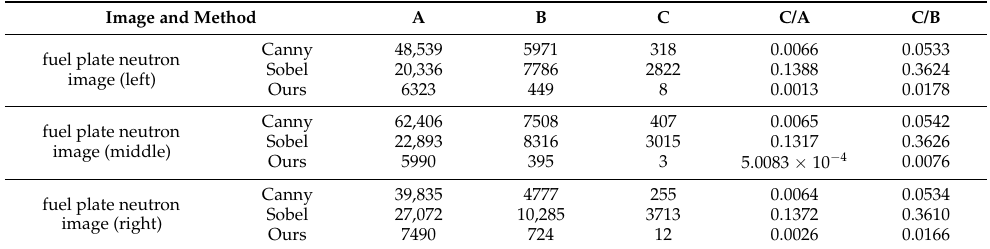
Table 2. Result of edge evaluation method based on connection component for plate fuel neutron images. Image and Method